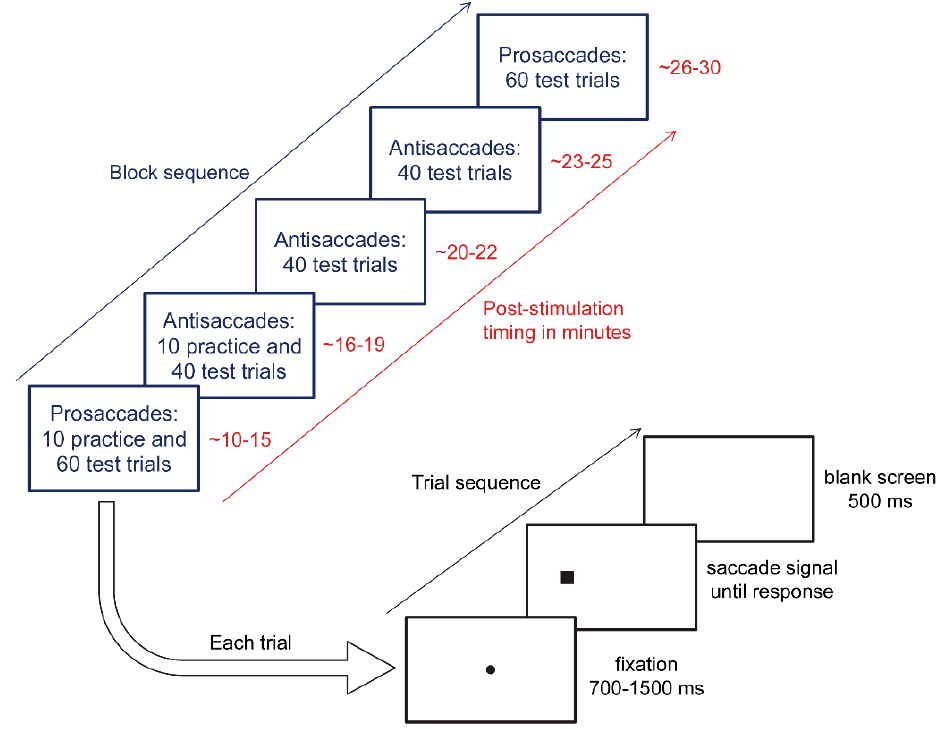
Figure 2. Eye tracking protocol adapted from Antoniades et al. [31].